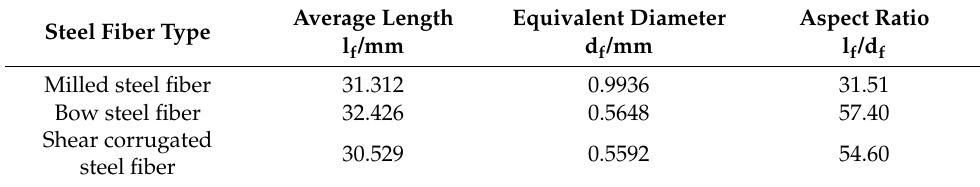
Figure 1. Sketch of the specimen shape and dimension. ( a ) Milled steel fiber; ( b ) Bow steel fiber; ( c ) Shear corrugated steel fiber. Shear corrugated steel fiber. Table 1. Material properties of the steel fiber types. Table 1. Material properties of the steel fiber